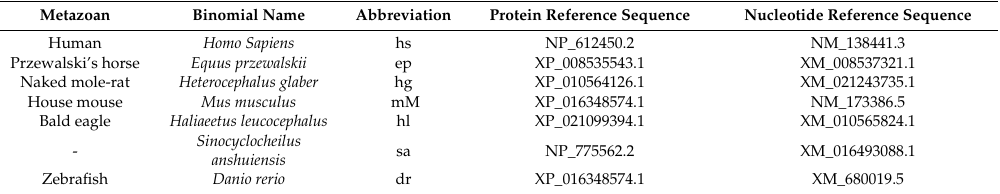
Figure A1. Reaction catalyzed by cGAS shown by GTP (blue), ATP (red), and cGAMP (green) concentrations. (A) truncated hscGAS (B) truncated hscGAS with sfGFP-tag. Error bars relate to biological triplicates ( A ) or duplicates ( B ). Table A1. References for protein and nucleotide sequences of cGAS homologues.